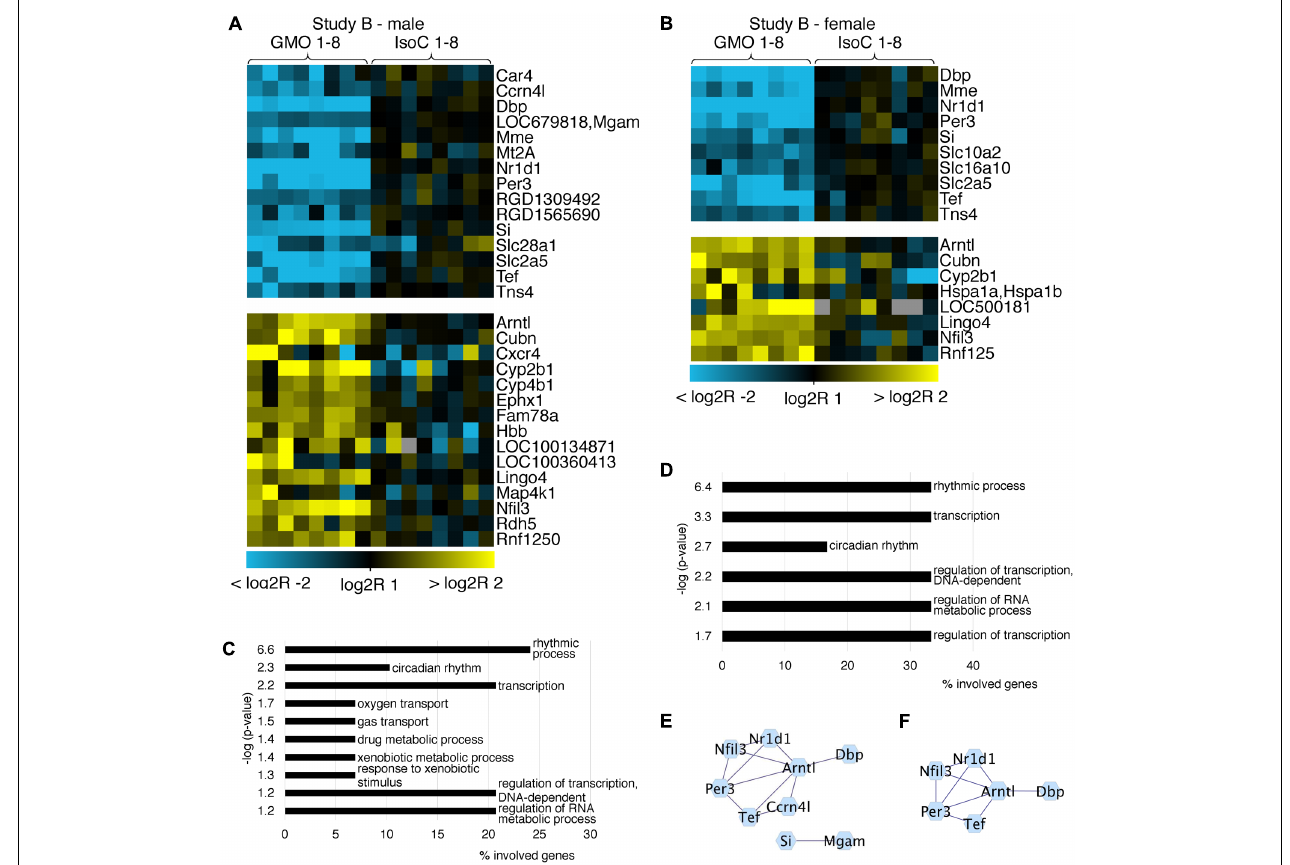
FIGURE 3 | Heatmap of differentially expressed genes and GO analysis. Heatmaps showing all differentially expressed genes with more than a twofold up- or down-regulation ( q < 0.05) in male (A) and female (B) animals of study B. GO analysis (C,D) of the differentially expressed genes (log2R > 1 or < –1) indicates pathways in which regulated genes show a highly significant enrichment in males (C) or females (D) . Networks of protein-protein interactions of males (E) or females (F) showing associations in sets of differentially expressed